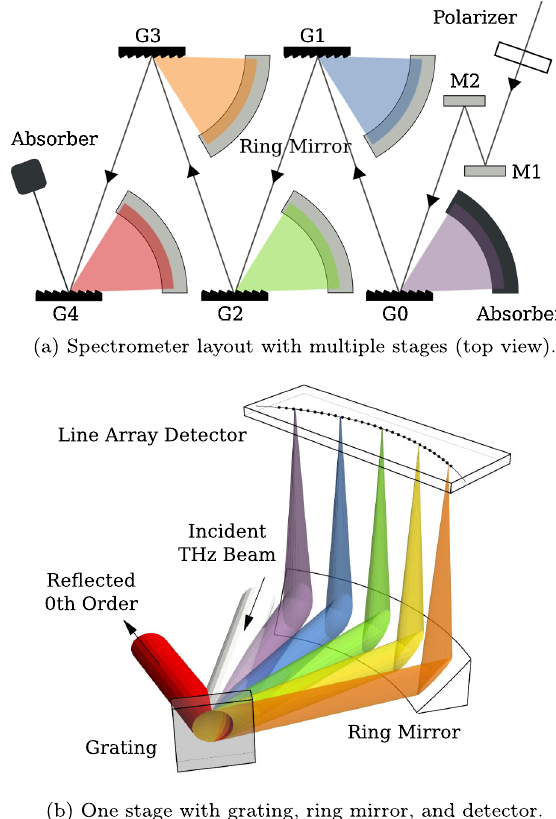
FIG. 2. Principle of the multichannel THz and infrared spec- trometer based on five stages of blazed reflection gratings in combination with focusing ring mirrors. The schematic layout is depicted in (a), and (b) shows one stage exemplarily (see Refs. [38,39] for technical details). The fast readout of the pyroelectric detector arrays allows single-shot